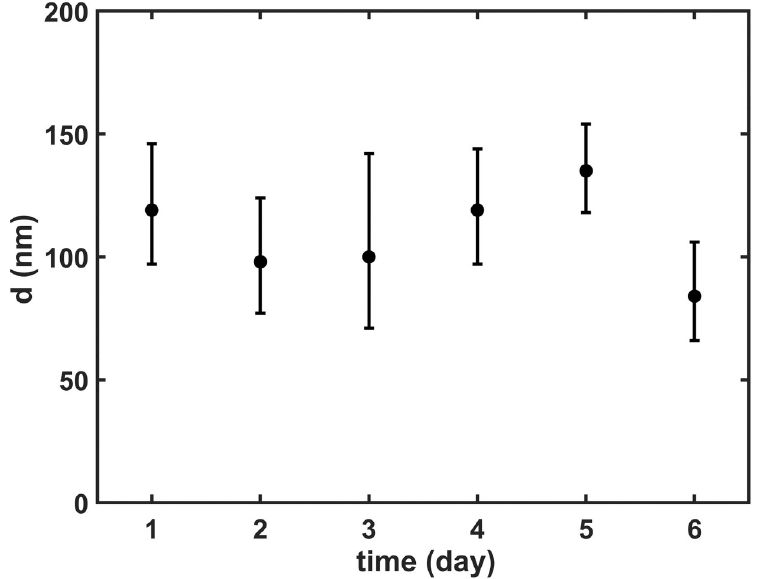
Fig 2. Stability of polyphosphate nanoparticles (PolyP-NPs). The particle size of the PolyP-NPs was monitored by dynamic light scattering (DLS) for 6 days as a measure of the preparation stability. Median particle diameters and interquartile range are shown (n = 100).